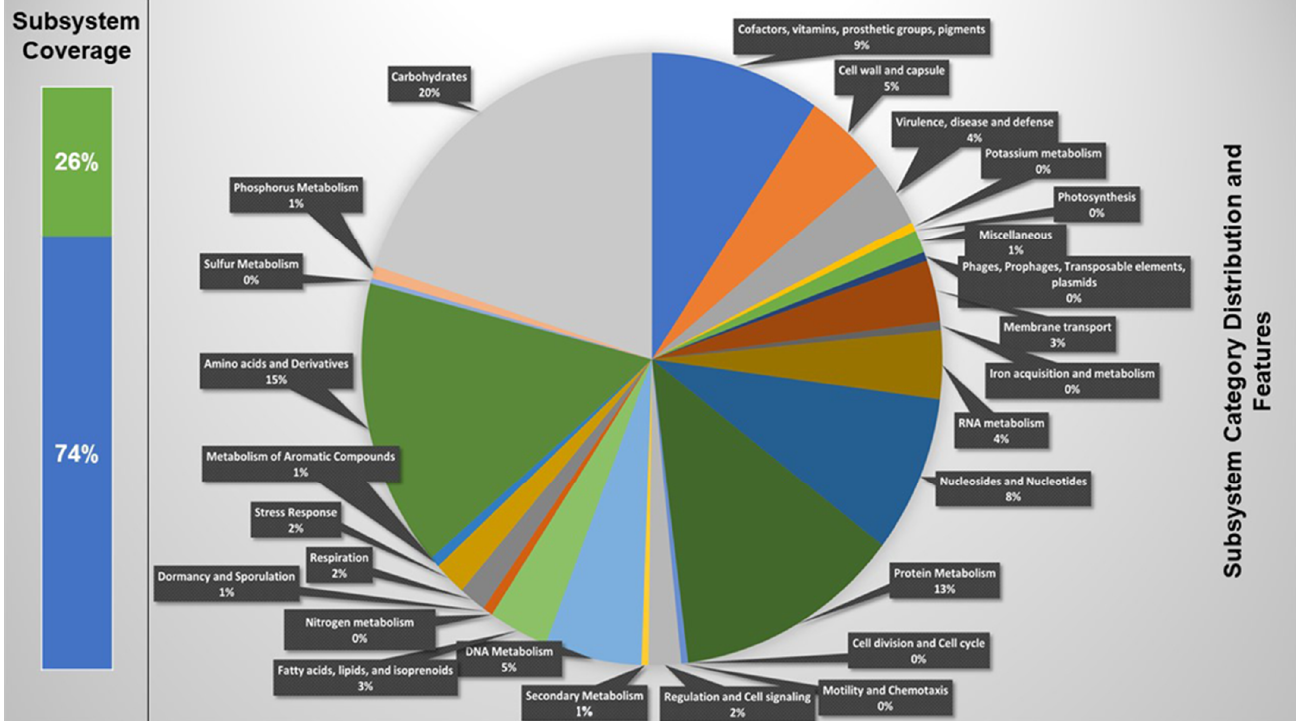
Figure 1. Subsystem coverage and distribution of Lp YW11 genome by